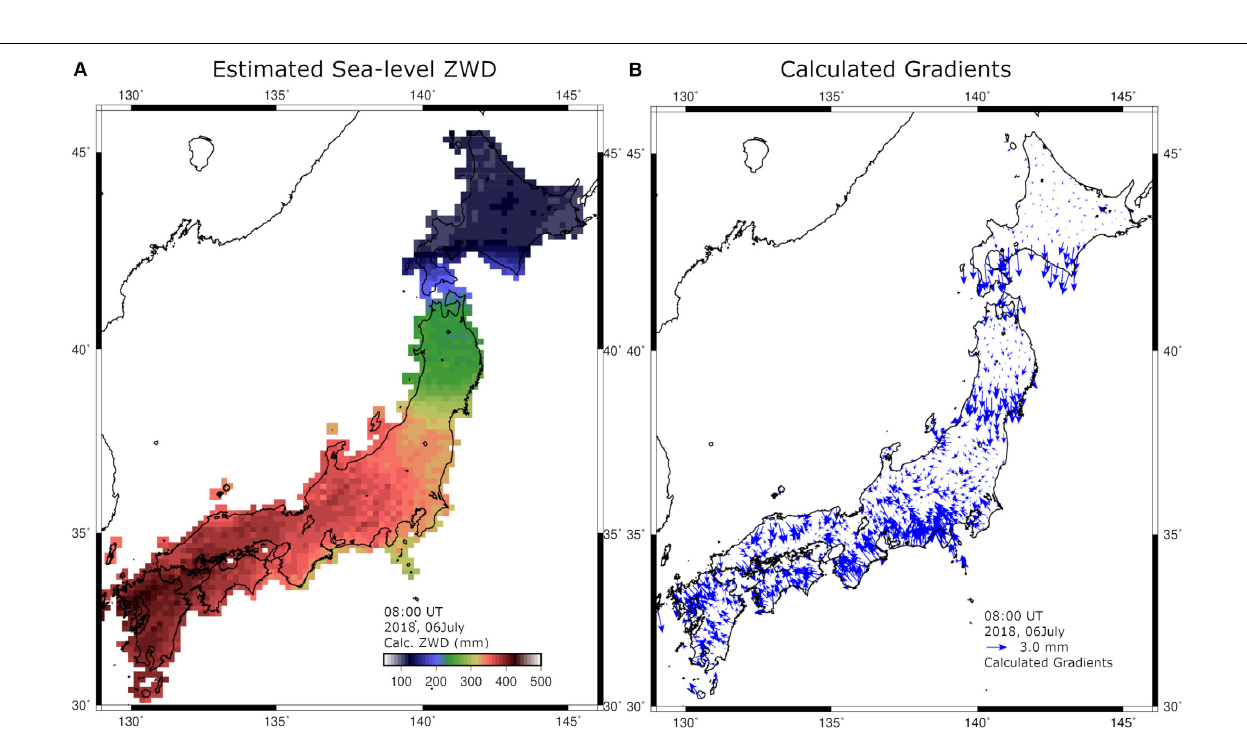
Frontiers in Earth Science |